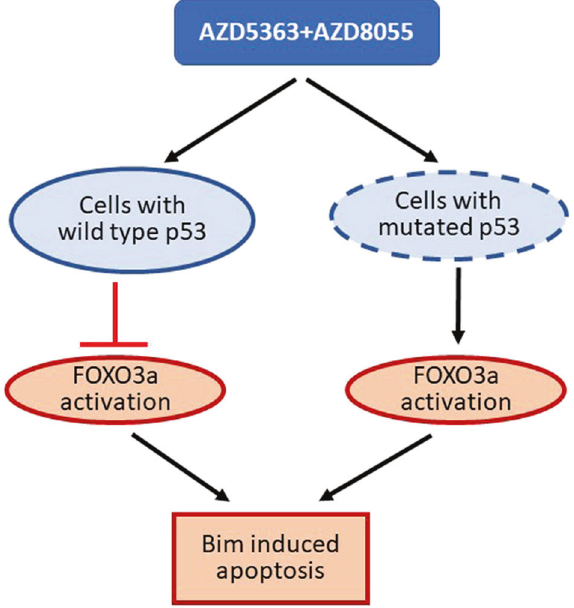
Fig. 7 Antiproliferative effect from a combination of AZD5363 and AZD8055 in HCC cells. Schematic presentation shows mechanistic steps of combined treatment inducing programmed death in HCC cells harboring wild-type or mutated